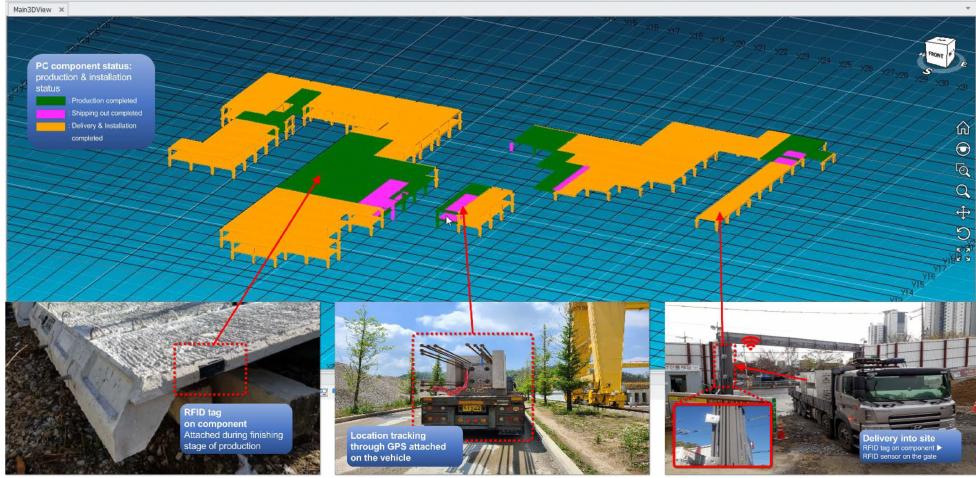
Figure 8. BIM- and RTLS-based logistics